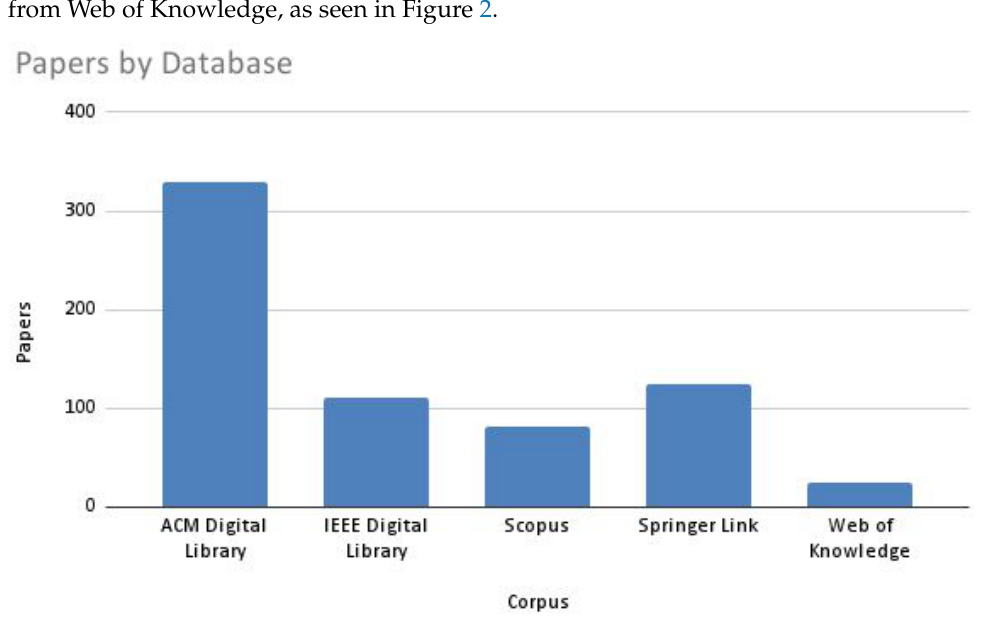
Figure 2. Initial corpus division by scientific articles